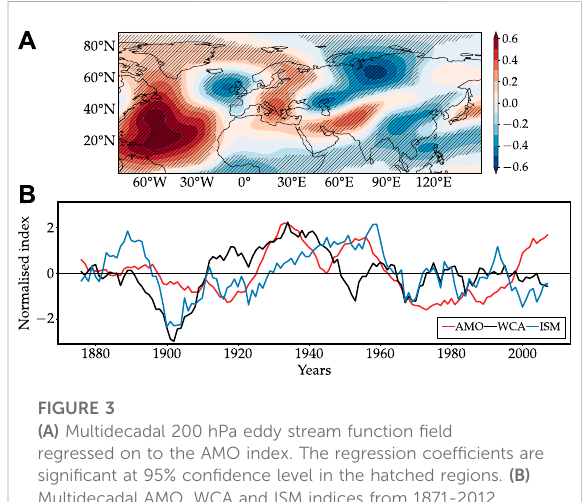
FIGURE 3 (A) Multidecadal 200 hPa eddy stream function fi eld regressed on to the AMO index. The regression coef fi cients are signi fi cant at 95% con fi dence level in the hatched regions. (B) Multidecadal AMO, WCA and ISM indices from